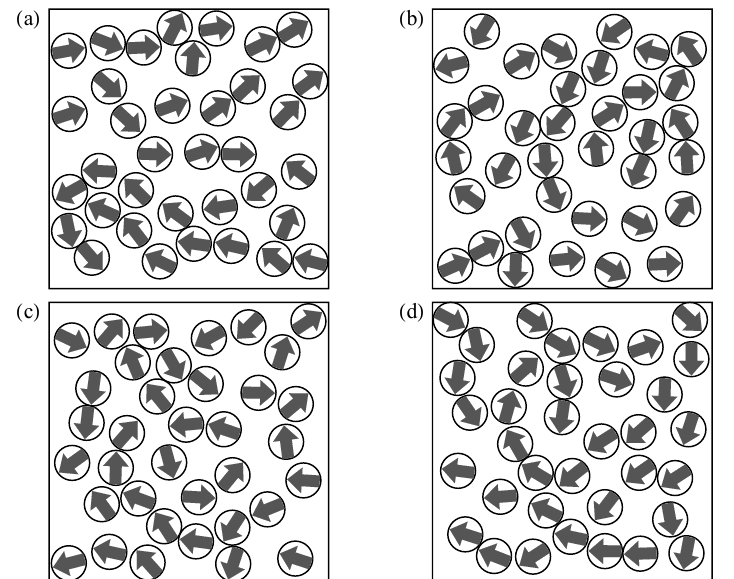
Figure 5. Ground-state magnetic configurations of representative strongly-disordered ensembles ( a – d ) of MNPs. The positions of the particles within the unit cell are indicated by the disks and the directions of the magnetic moments by the arrows. Notice that the magnetic configurations are dominated by short-range correlations between the local